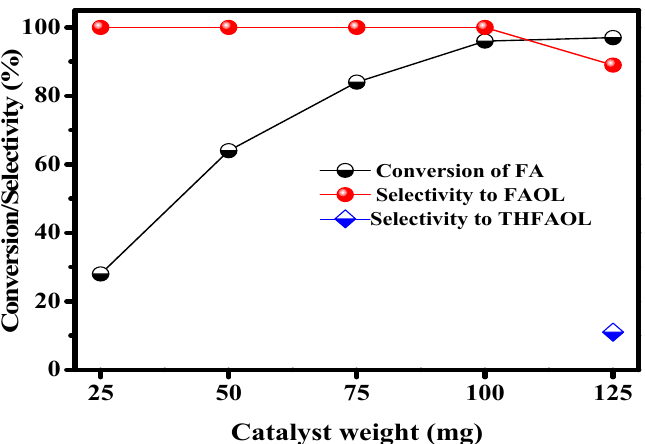
Figure 9. The effect of catalyst weight (mg) on the CTH of FA over 5CuHAp catalyst. Reaction conditions: catalyst amount (25–125 mg), 2-propanol (5 mL), FF (480 mg), reaction temperature—140 °C at 2 MPa N 2 pressure and reaction time—4 h.